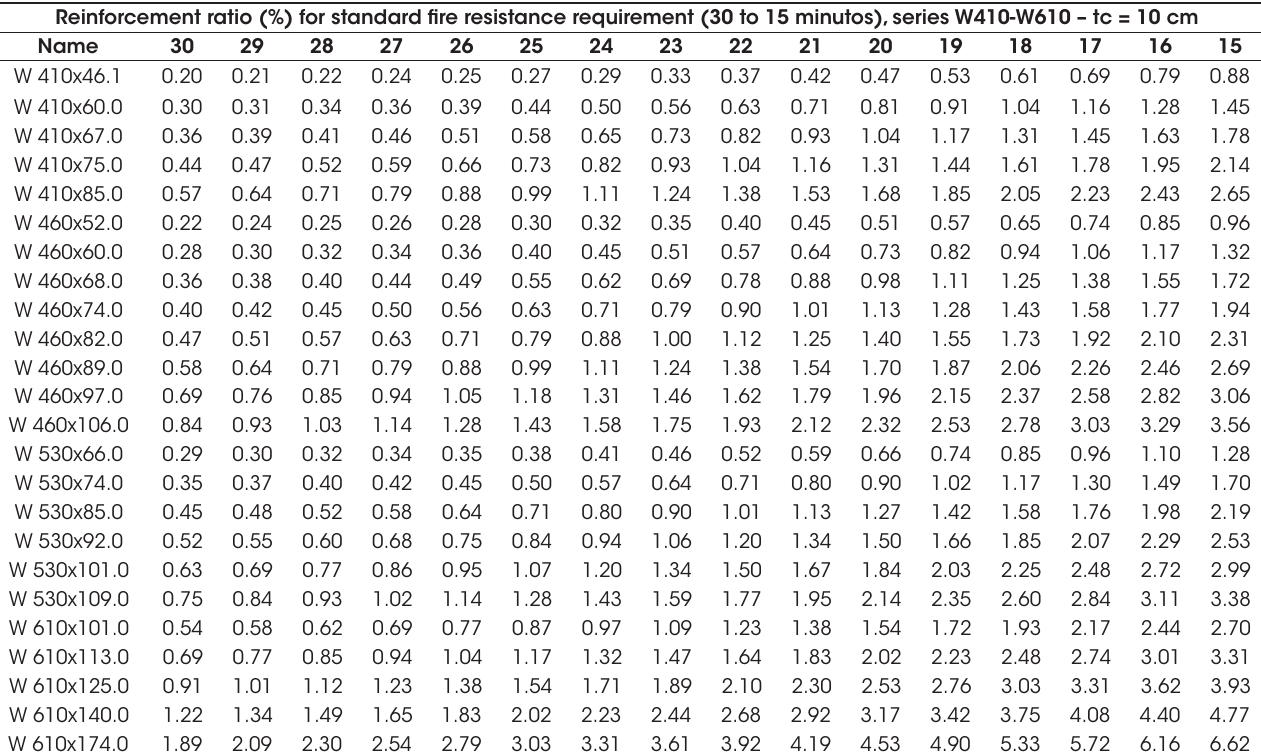
Reinforcement ratio as function of the standard fire resistance requirement for development of the maximum negative bending moment, for composite beams with 10 cm slabs and Gerdau profiles series